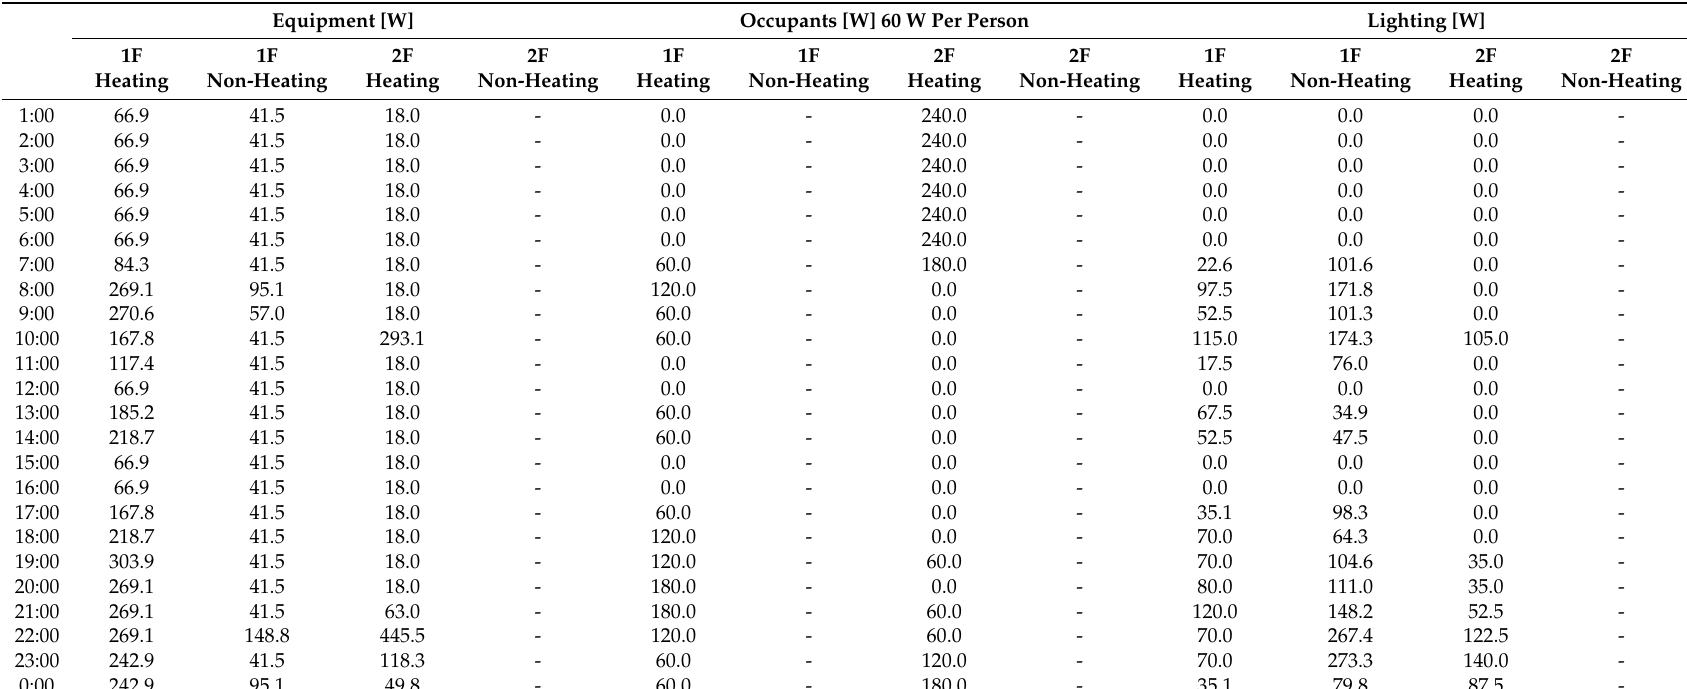
Table 3. Internal heat gains for